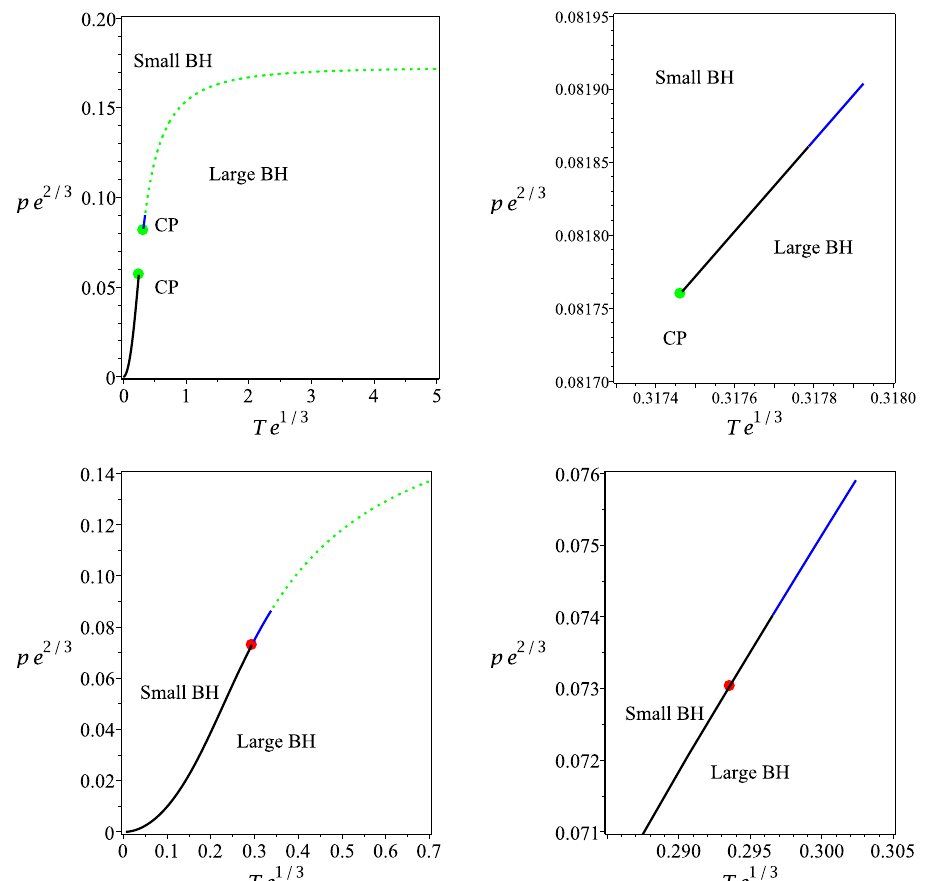
Figure 22 . Phase diagrams depicting (cid:12)rst and second order phase transitions in d = 6. Top left : choosing (cid:22)=e 4 = 3 (cid:25) (cid:0) 0 : 065487 the critical quantities are T c e 1 = 3 (cid:25) 0 : 24730 and P c e 2 = 3 (cid:25) 0 : 05712, T c e 1 = 3 (cid:25) 0 : 31746 and P c e 2 = 3 (cid:25) 0 : 08175. Green points denote critical points and black lines indicate a (cid:12)rst-order phase transition. We see that there is such a transition for T < T c and another for T > T c . Blue lines indicate negative entropy; green dotted lines indicate negative mass. Top right : a magni(cid:12)cation of the region near the upper right critical point in the (cid:12)gure to the left, illustrating the existence of a small region with positive entropy (solid black line). Bottom left : for (cid:22)=e 4 = 3 (cid:25) (cid:0) 0 : 068658 we obtain an isolated critical point (red point); the approximate values at the conjoined critical temperature and volume are T c e 1 = 3 (cid:25) 0 : 2766075924 and P c e 2 = 3 (cid:25) 0 : 06725819565. Bottom right : a magni(cid:12)cation of the bottom left plot close to the isolated critical